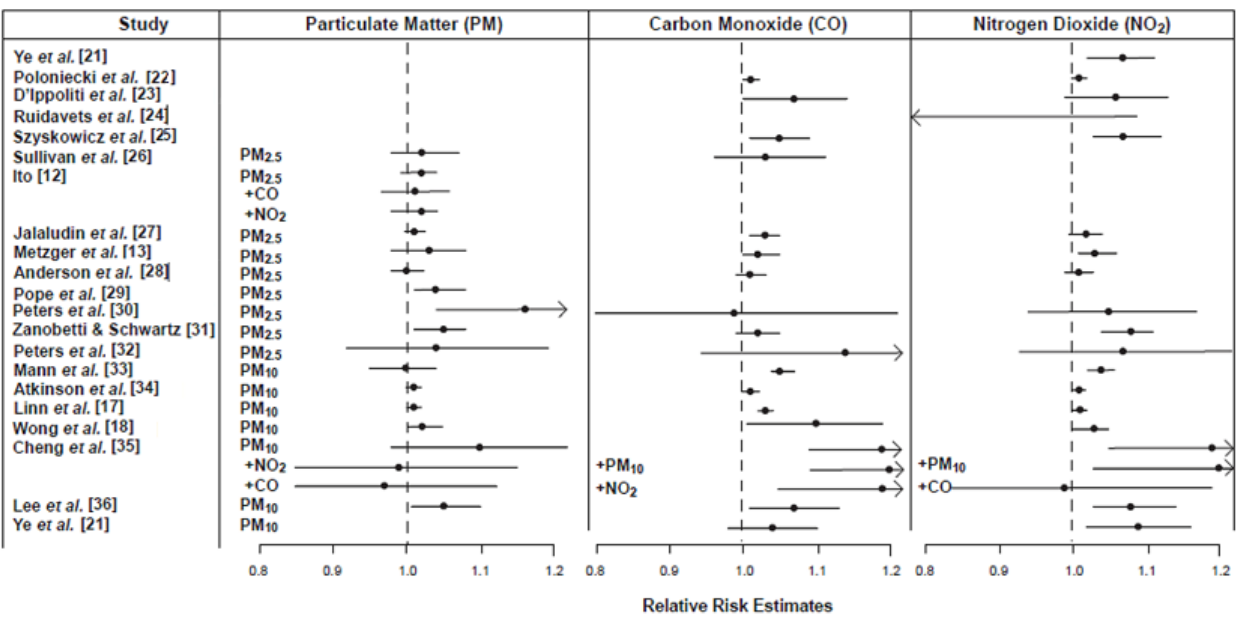
Figure 2. Effect estimates and 95% Confidence Intervals for Studies of Ischemic heart Disease (IHD) and Myocardial Infarction (MI) included in the